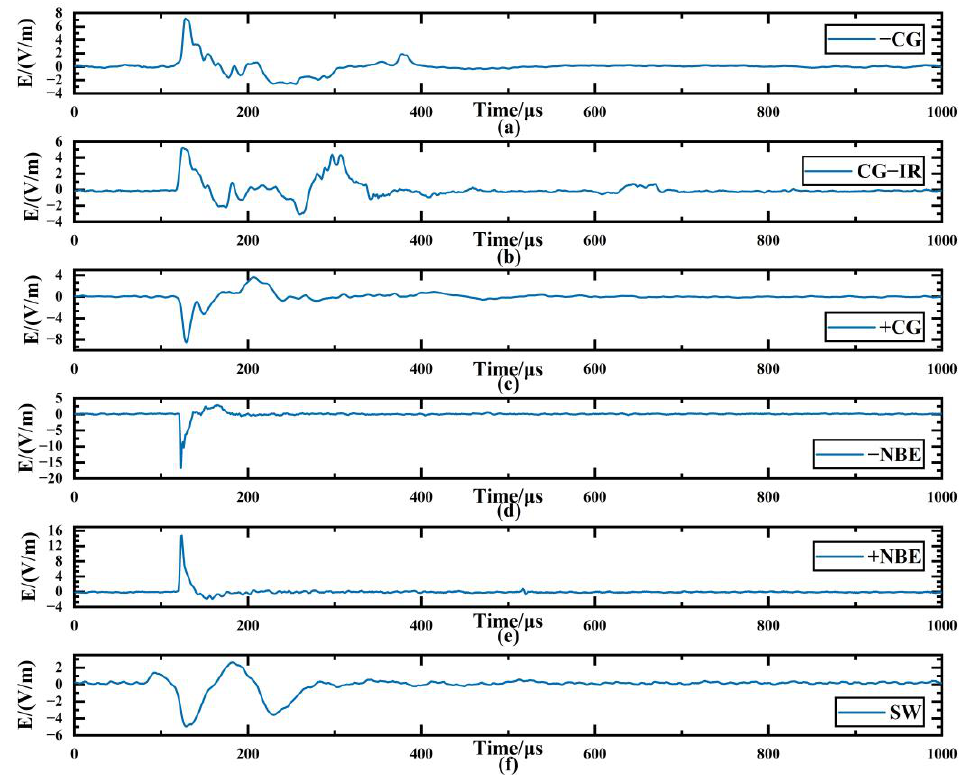
Figure 4. Examples of various lightning electromagnetic pulse waveforms. ( a ) negative cloud-to- ground flash ( − CG); ( b ) positive cloud-to-ground flash (+CG); ( c ) negative narrow bipolar event ( − NBE); ( d ) positive narrow bipolar event (+NBE); ( e ) cloud ground flash with ionosphere reflected signals (CG-IR); ( f ) far-field skywave (SW).